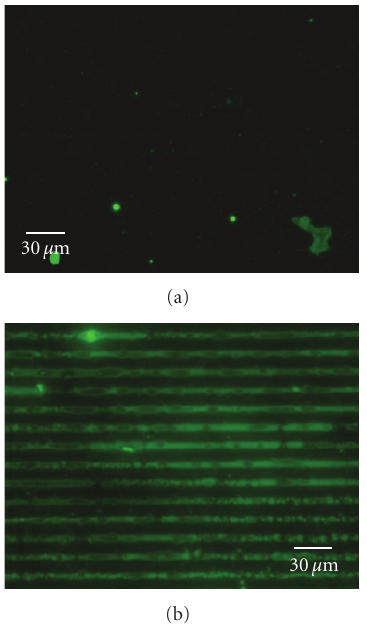
Figure 5: Fluorescence image of capture surface assay utilizing Alexa Fluor conjugated avidin: (a) blank and (b) G4 biotinylated PAMAM dendrimers bound to avidin capture